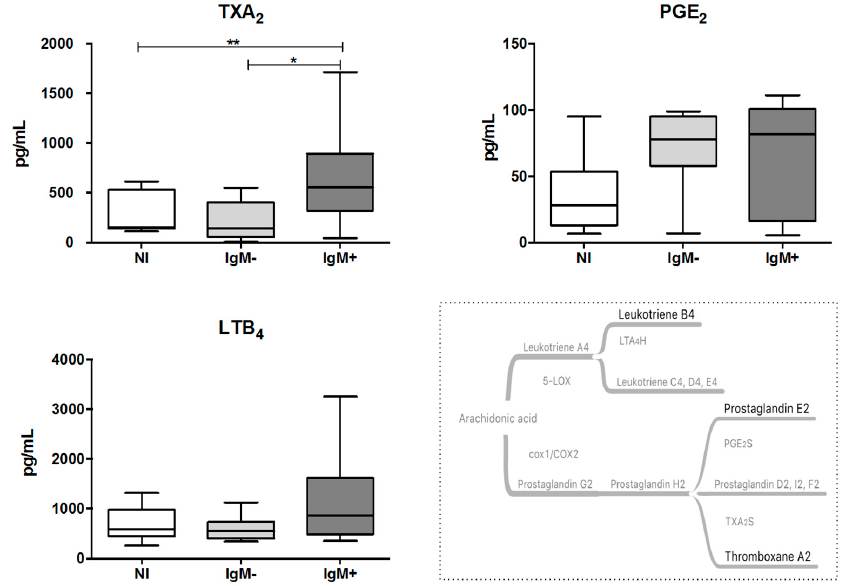
Figure 1. Quantification of eicosanoid TXA 2 , PGE 2 and LTB 4 in plasma from dengue-infected individuals. The eicosanoids were quantified in plasma samples using commercial ELISA kits. Data represent the median, quartiles and extreme values. NI = Non-infected individuals ( n = 12). IgM − = DENV-infected individuals showing the absence of IgM in plasma ( n = 12). IgM + = DENV-infected individuals showing the presence of IgM in plasma ( n = 1). (*) p < 0.05 and (**) p < 0.01, TXA 2 and LTB 4 were determined by ANOVA/Student Newman–Keuls test, and PGE 2 was determined by the Kruskal–Wallis/Dunn’s method.